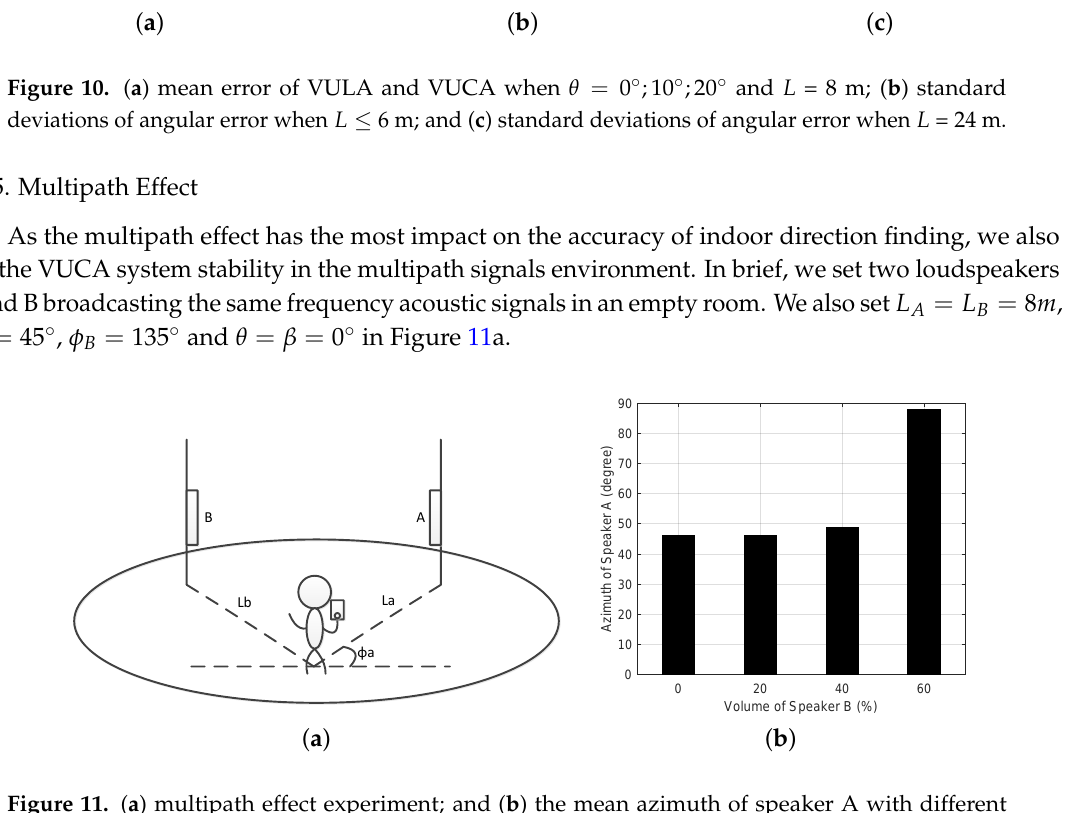
Figure 11. ( a ) multipath effect experiment; and ( b ) the mean azimuth of speaker A with different volumes of speaker B.